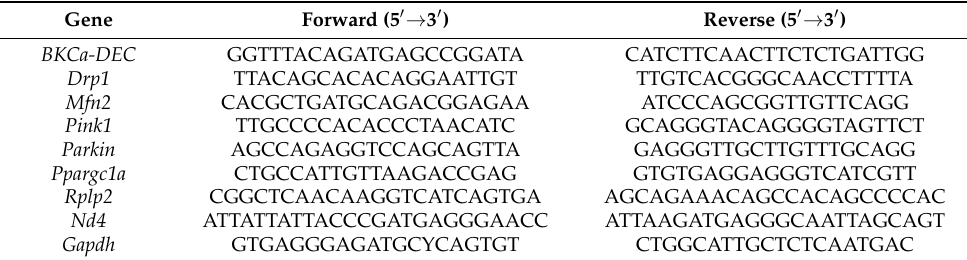
Table 1. Oligonucleotide sequences of the RT-PCR primers. Gene Forward (5 (cid:48) → 3 (cid:48) ) Reverse (5 (cid:48) → 3 (cid:48)